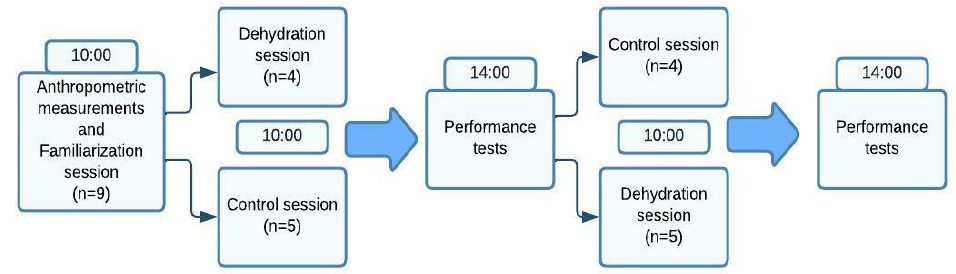
Figure 1. Study Figure 1. Study Design.